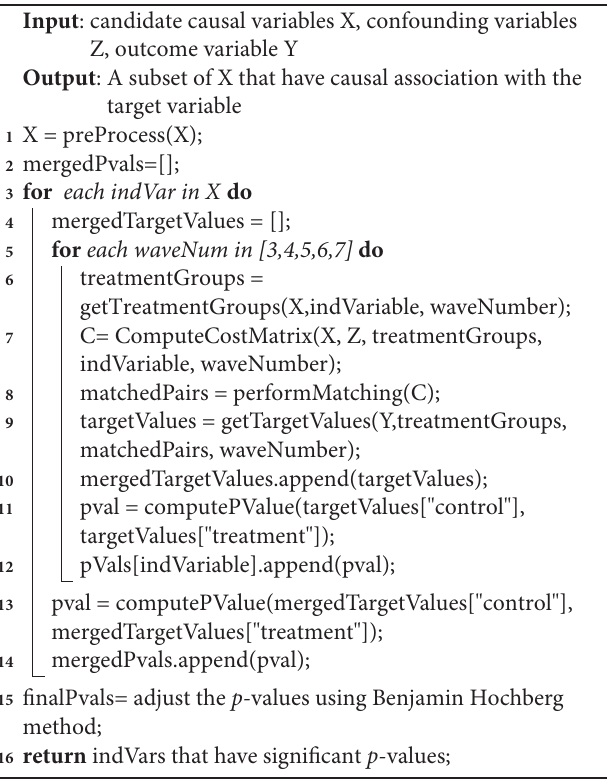
Algorithm 1: Causal Discovery